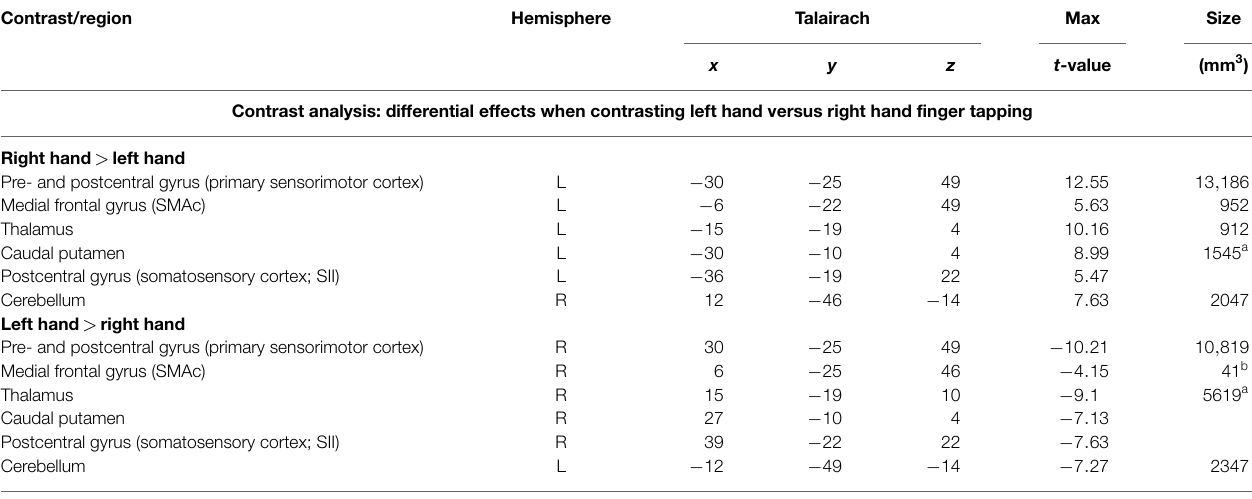
FIGURE 3 | Conjunction analysis (top) and contrast analysis (bottom) of left hand and right hand finger movements . In the contrast analysis, regions more active during left hand movement are labeled in yellow/orange, those more active during right hand movement are labeled in green/blue. Time courses represent from top to bottom signal changes of rostral